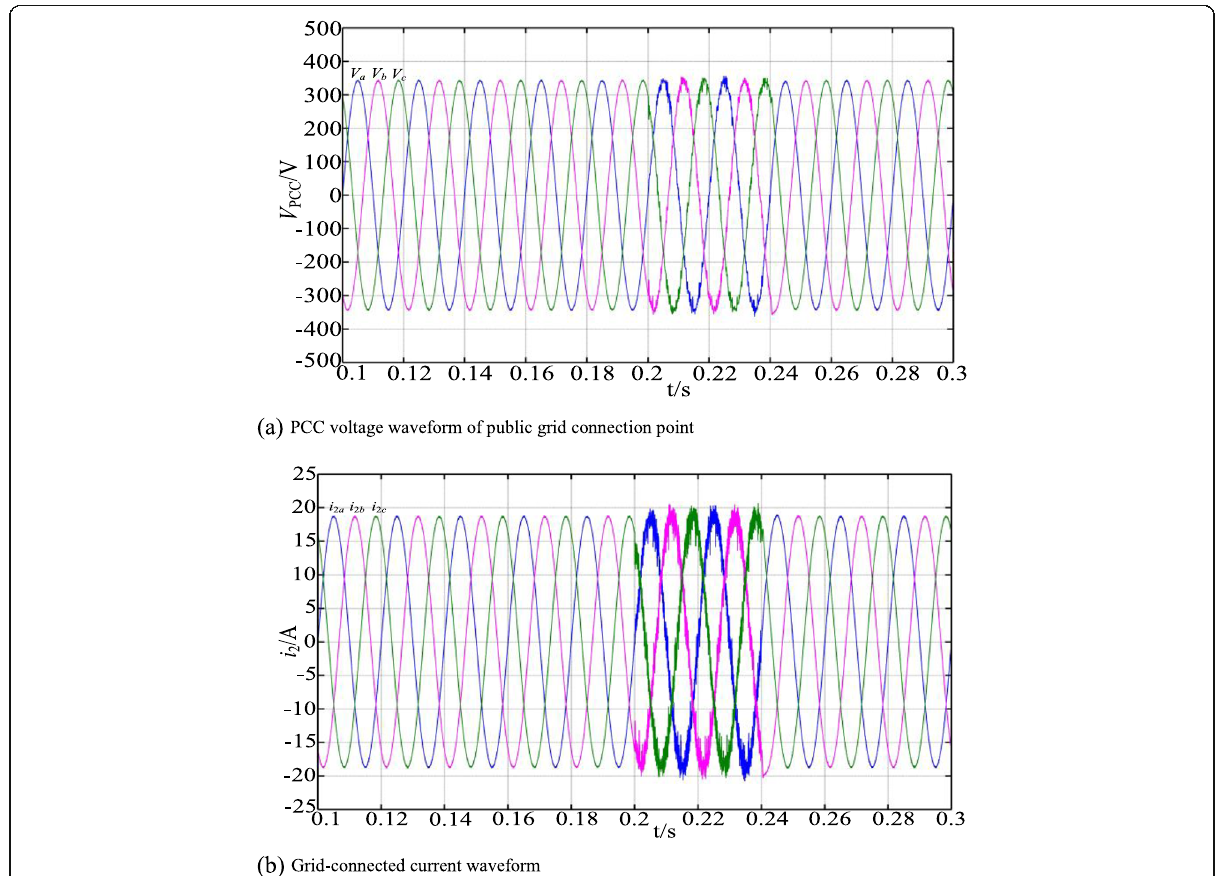
Fig. 13 Simulation waveform diagram of traditional and improved method switching process. a PCC voltage waveform of public grid connection point. b Grid-connected current